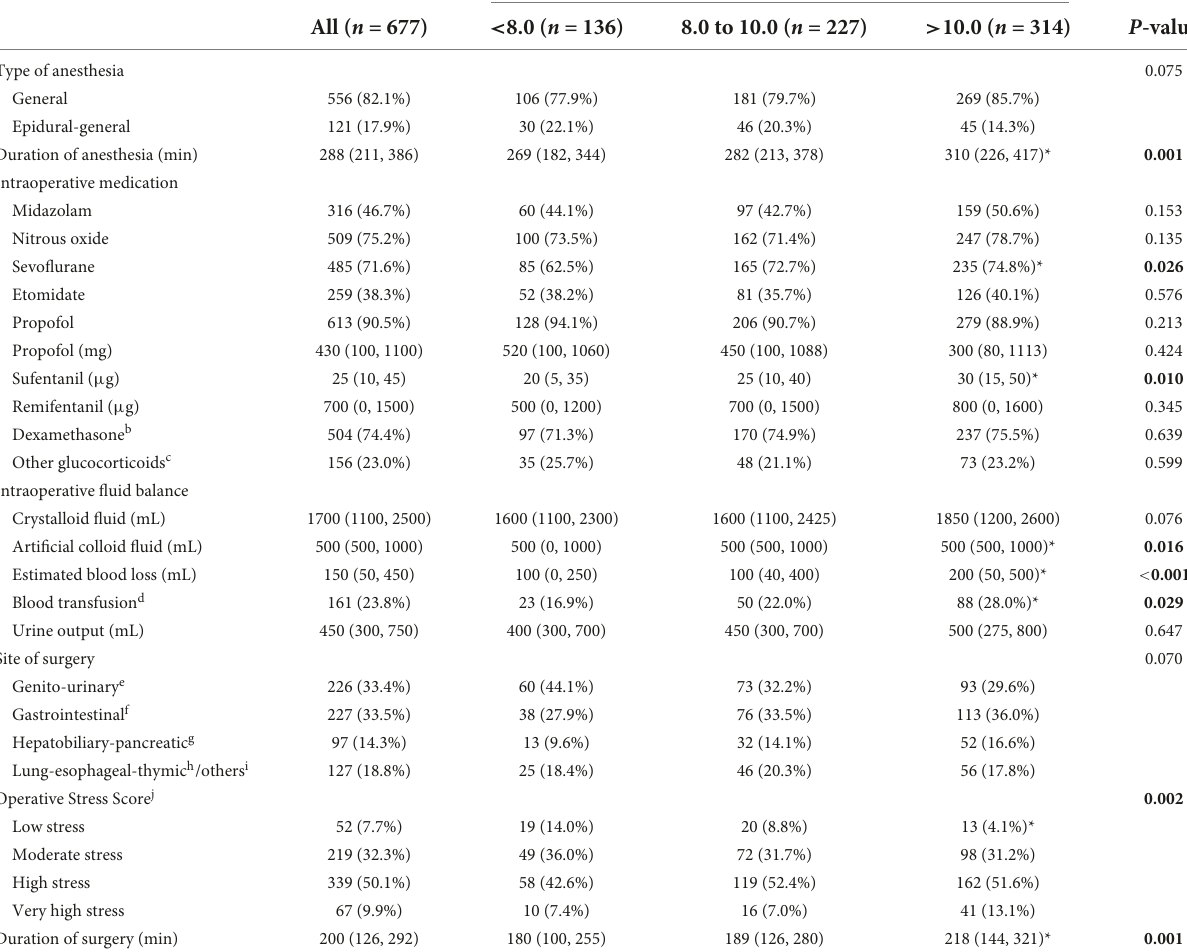
TABLE 2 Intraoperative